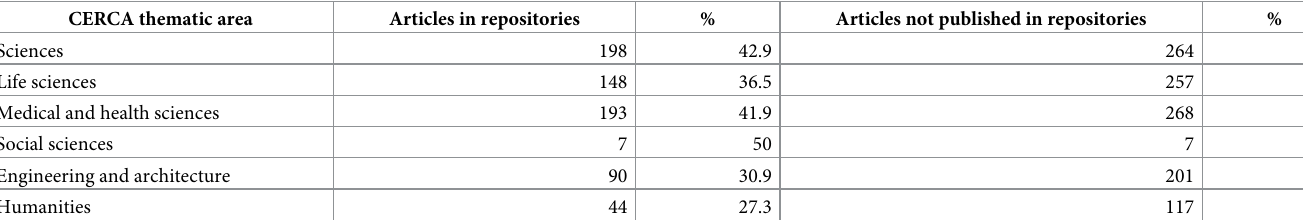
Table 15. 2013–2015 articles linked to competitive state projects published in repositories. CERCA thematic area